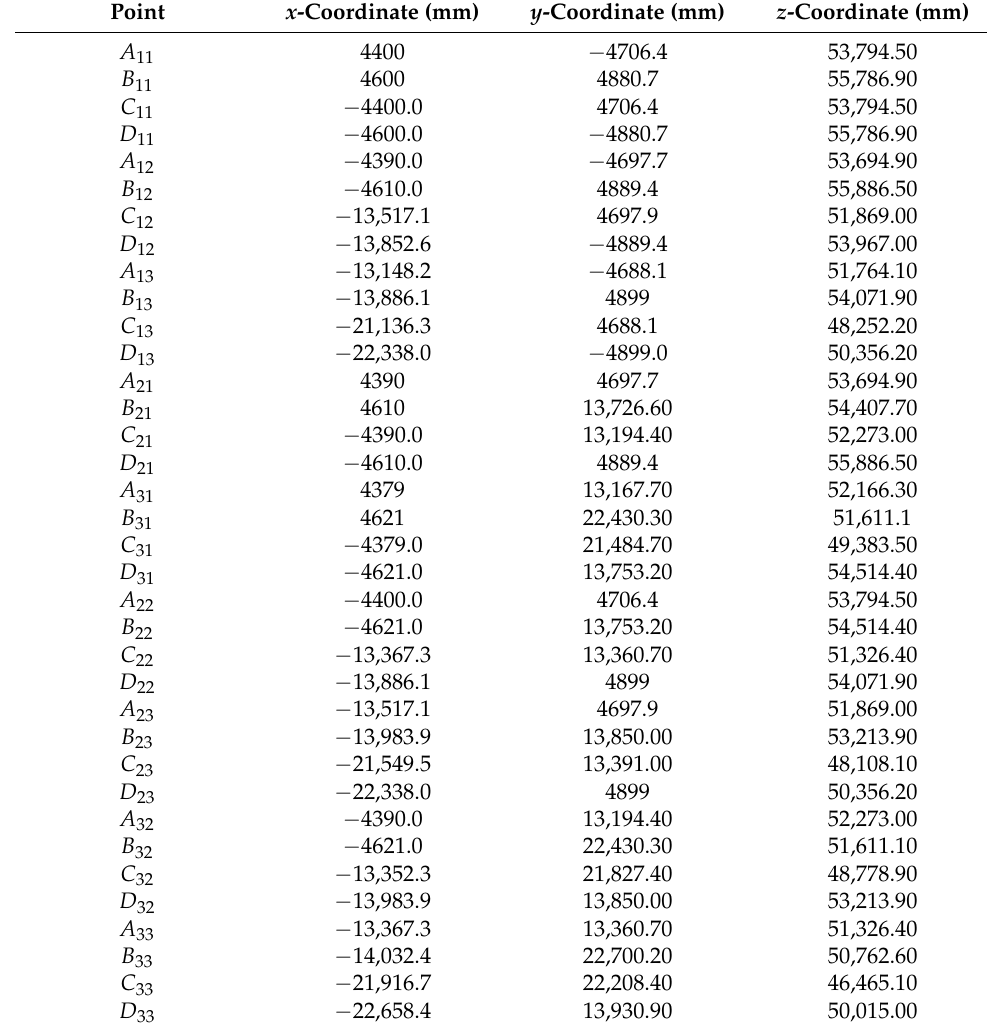
Table A3. The coordinates of the vertices A ij , B ij , C ij , D ij (for i, j = 1, 2, 3) of the eaves edge net B v 1